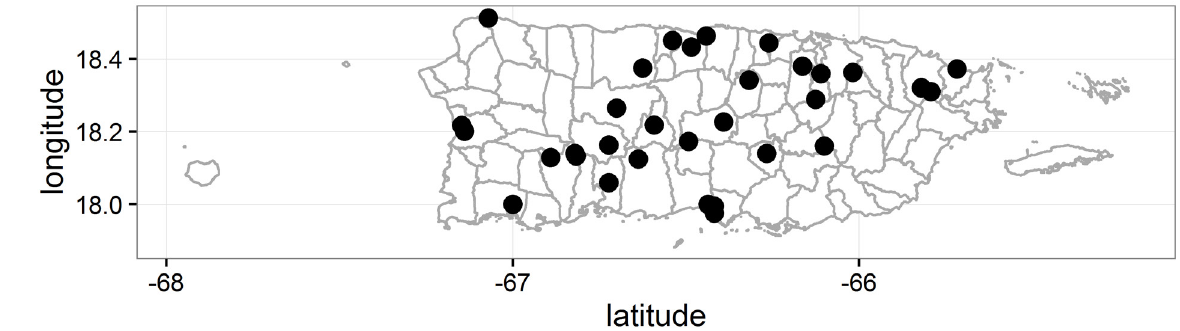
Fig. 23. Distribution map for Lasioglossum gundlachii (Baker, 1906) in Puerto